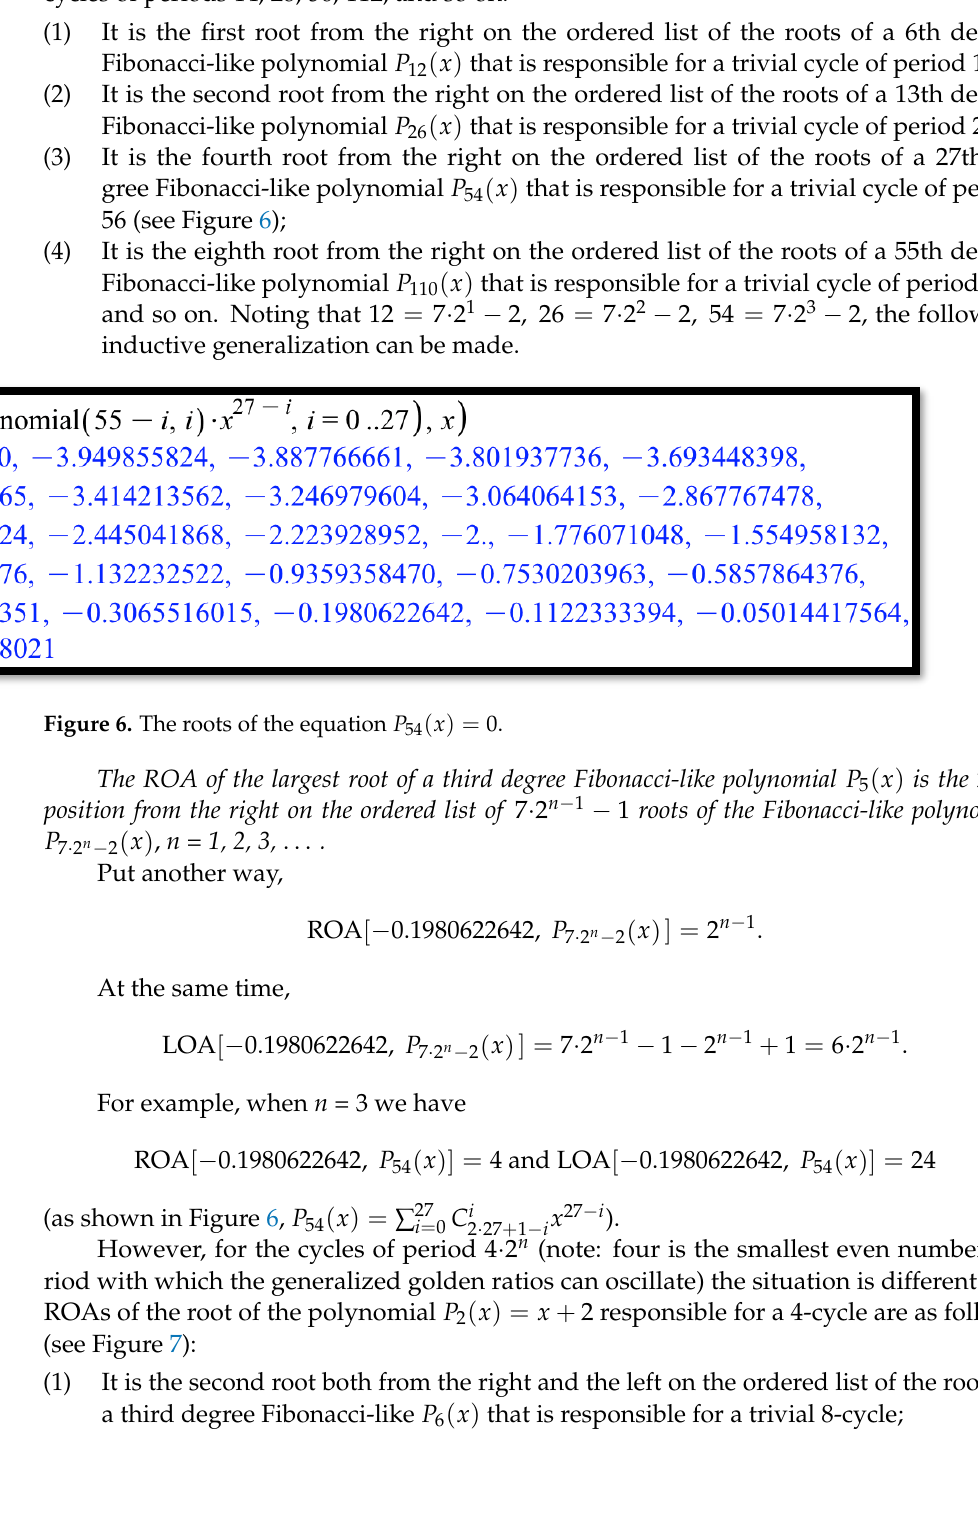
Figure 7. ROAs and LOAs of the root of 𝑃 2 (𝑥) = 𝑥 + 2. 4.3. The Case of the Smallest Root of the Polynomial 𝑃 3 (𝑥) In much the same way, one can find the LOAs for the smallest root of a second degree Fibonacci-like polynomial 𝑃 3 (𝑥) = 𝑥 2 + 3𝑥 + 1, which is also responsible for a 5-cycle, on the ordered list of the roots of the Fibonacci-like polynomials responsible for the cycles of periods 10, 20, 40, 80, and so on. This root, −3−√5 2 ≈ −2.618034 , coincides with: (1) The second root from the left on the ordered list of the roots of a fourth degree Fibonacci-like polynomial 𝑃 8 (𝑥) that forms a trivial 10-cycle from two identical 5- cycles;